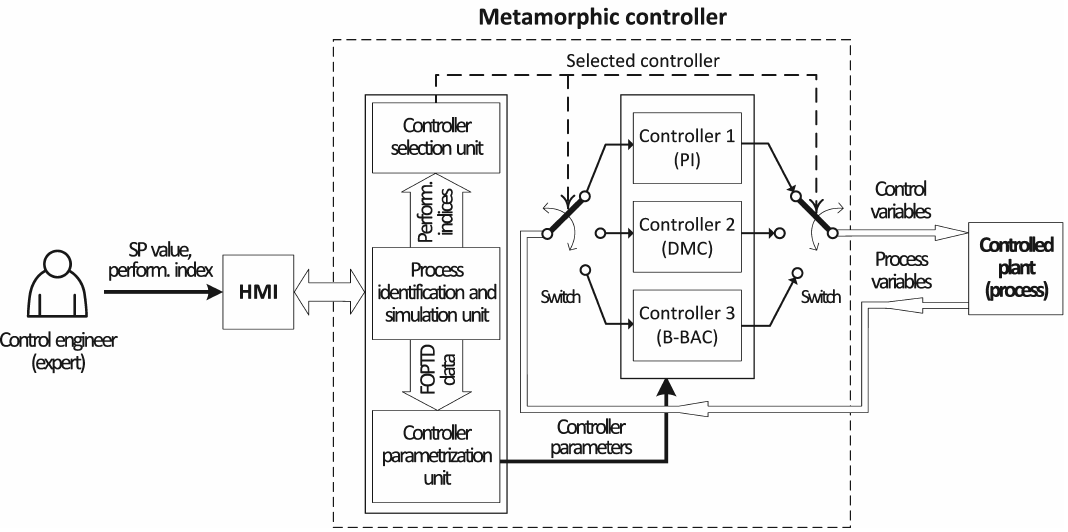
Figure 4: The general scheme of the metamorphic controller and its connection with the plant. (first order element), and FB8 (nonlinear